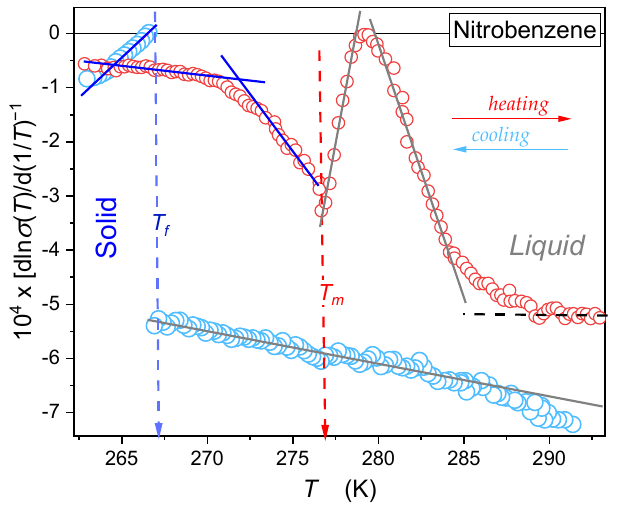
Figure 6. Temperature changes of the steepness index reciprocals (Equations (12) and (13)). Linear changes are related to the ‘universal’ pattern given by Equation (15). Note that for the premelting behavior in the solid phase, the evolution is related to the singular behavior associated with T + ≈ T m .